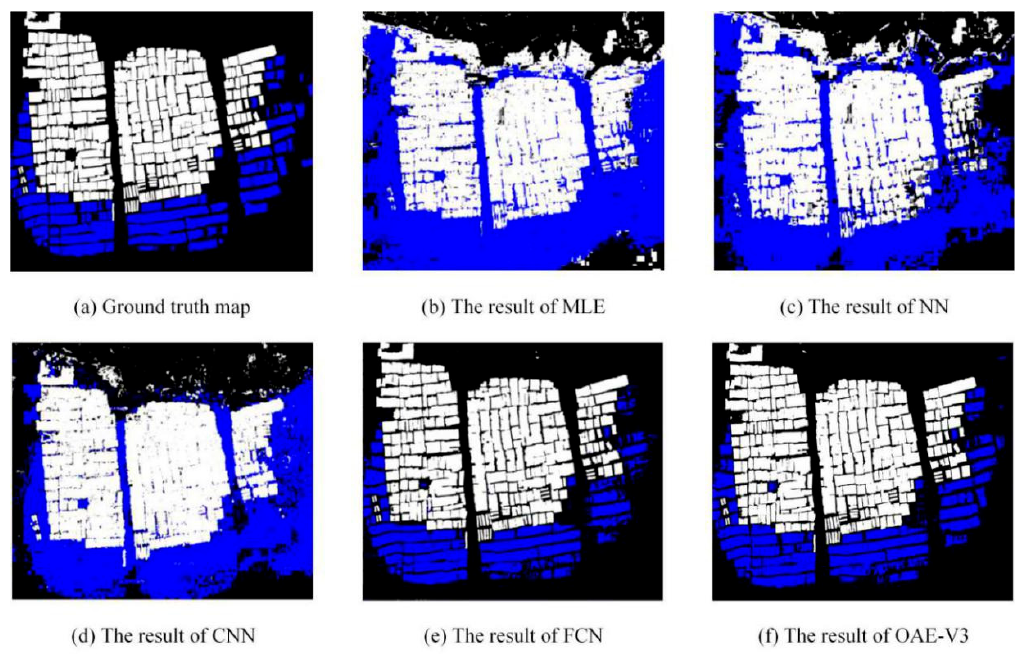
Figure 13. ( a ) The ground truth map; ( b ) the results of MLE; ( c ) the results of NN; ( d ) the results of CNN; ( e ) the results of FCN; ( f ) the results of OAE-V3. (The black is the background, white is fish row cage aquaculture, and blue is floating raft aquaculture.) The method proposed in this paper (OAE-V3)